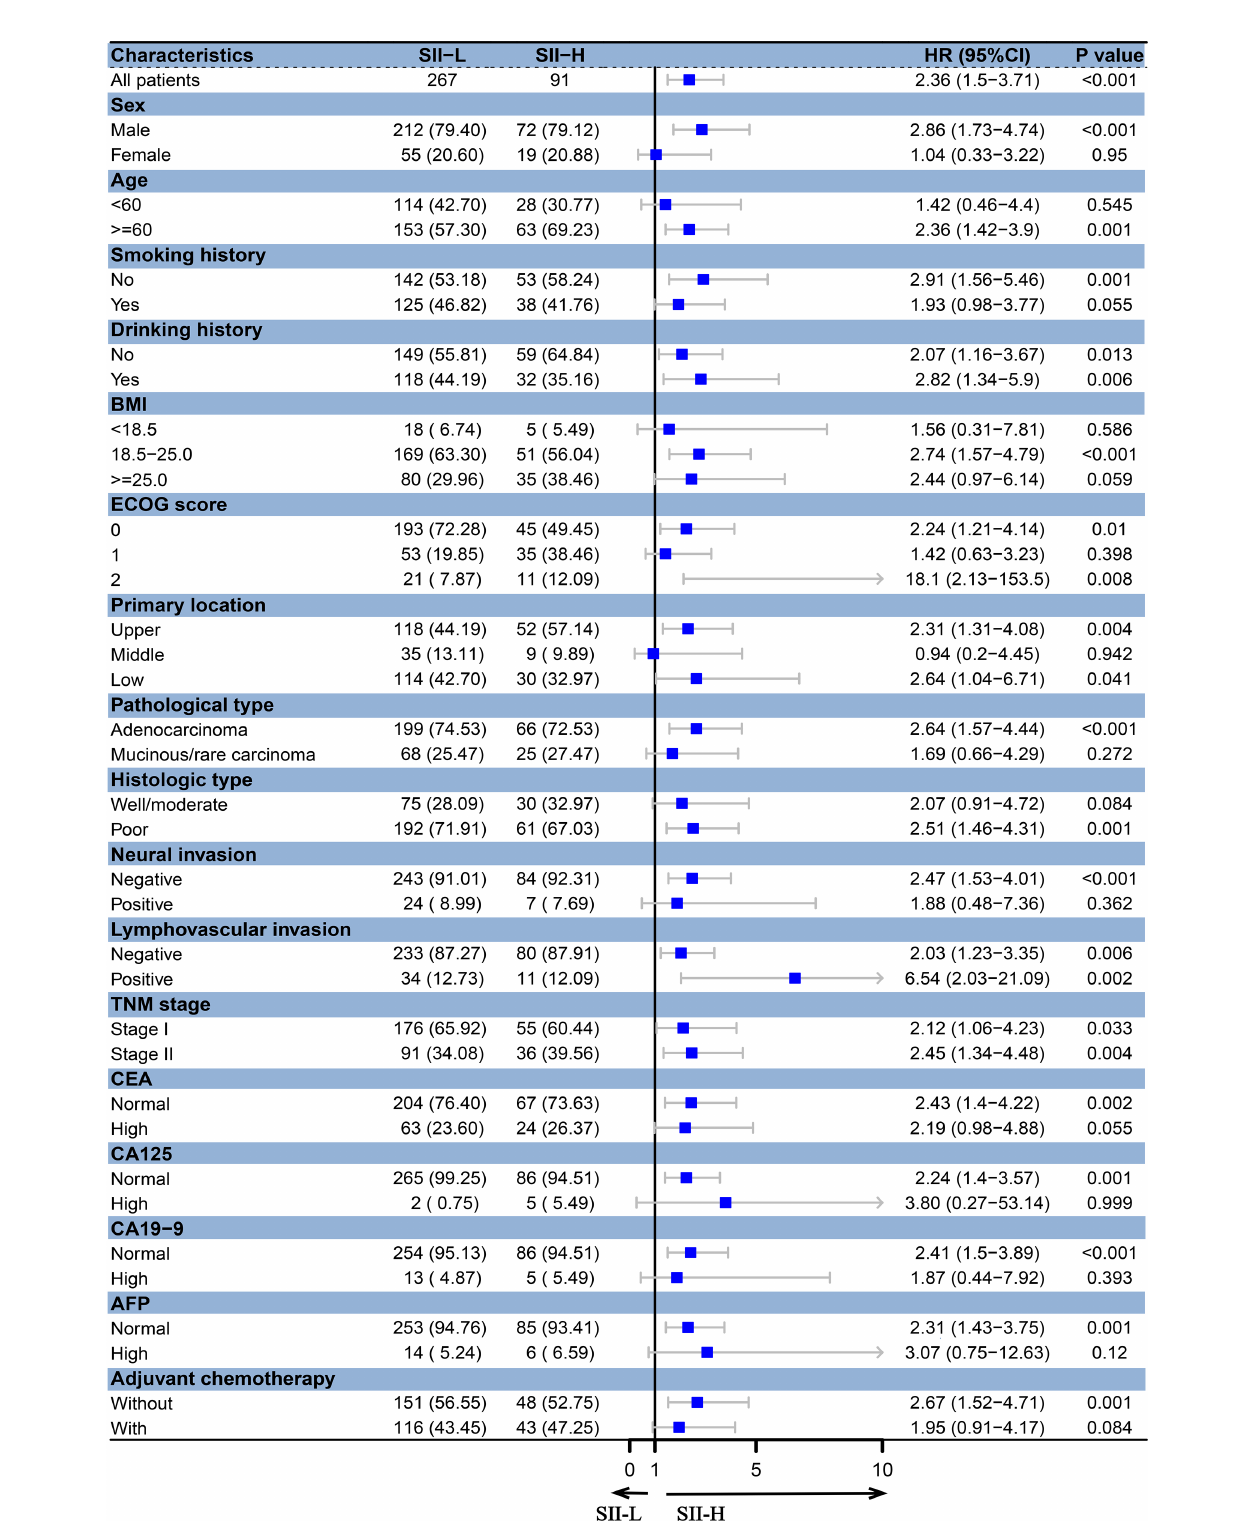
FIGURE 4 | Forest plots for subgroup analyses of SII in stage I – II GC. BMI, body mass index; ECOG, Eastern Cooperative Oncology Group; CEA, carcinoembryonic antigen; CA125, cancer antigen 125; CA19-9, carbohydrate associated antigen 19-9; AFP, alpha-fetoprotein.